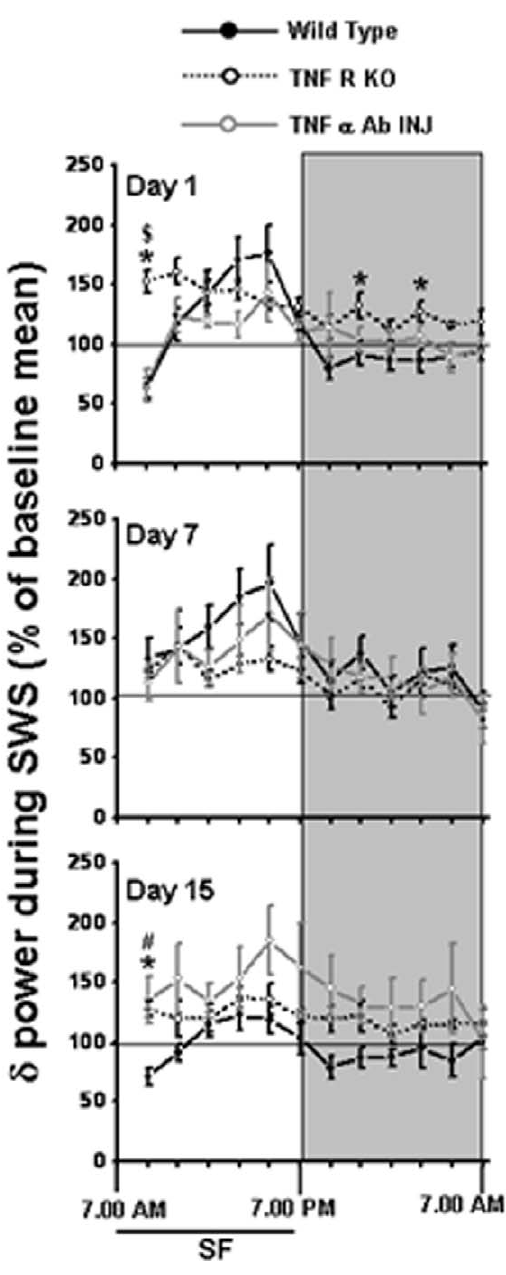
Figure 4. EEG delta power during SWS in WT, TNF R KO and TNF- a antibody injection mice. Comparison of normalized EEG delta power in WT (solid bar), TNF R KO (dashed line) and TNF- a antibody injection (grey mice). The black line indicates SD period (7.00 am to 7.00 pm). ). SF, sleep fragmentation. p , 0.05. *=comparison between WT and TNF R KO during respective post-fragmented days. $=comparison between WT and TNF R KO.